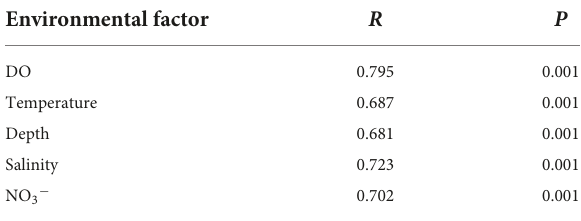
TABLE 2 Mantel test results for environmental factors and bacterial community composition at the OTU level.